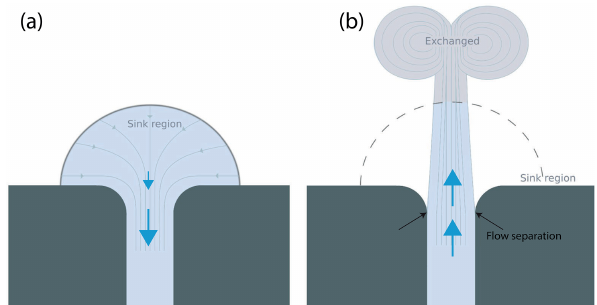
Figure 1. A sketch of the processes at play in water exchange by tidal pumping. (a) Southward inflow to the strait. (b) Northward outflow from the